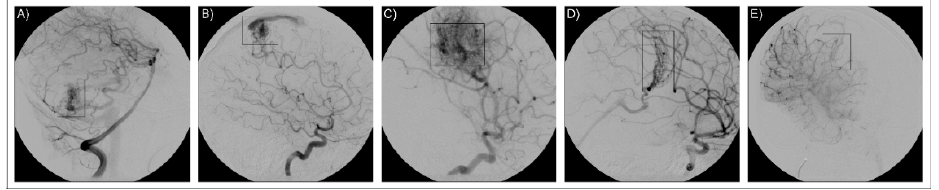
Figure 3. Imaging for neuroradiological diagnosis. The figure reports cerebral angiographies that confirm the presence of bAVM lesions. The five images refer to the five patients as reported in the text: ( A ) AVM1, ( B ) AVM2, ( C ) AVM3, ( D ) AVM4, ( E ) AVM5. AVM lesions are framed in the rectangular box.